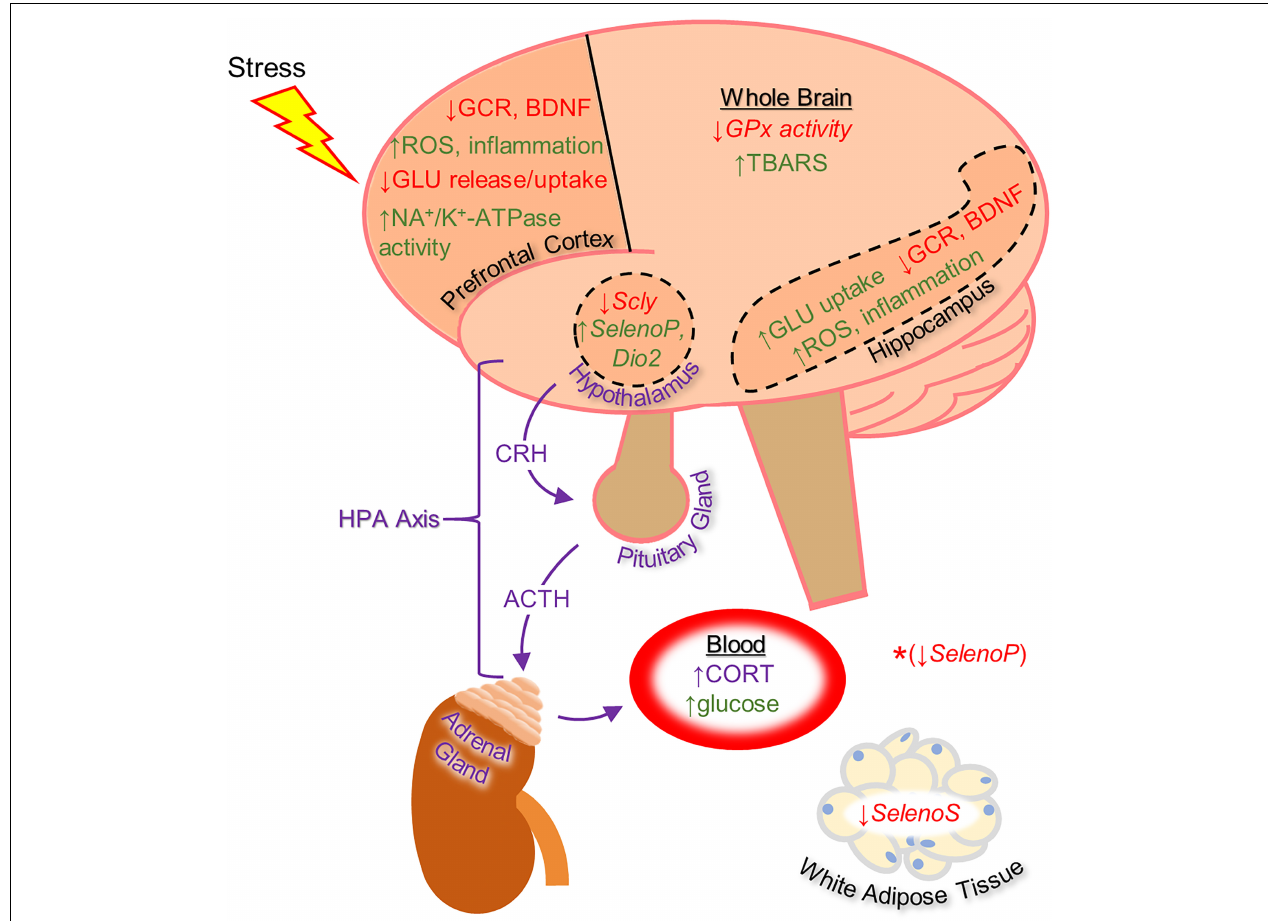
FIGURE 1 | Diagram of the effects of heightened stress on the brain and other tissues as well as on the function of the hypothalamic-pituitary-adrenal (HPA) axis (in purple), based mainly on rodent studies. The effects shown include regulation of selenoprotein expression by glucocorticoid administration (shown with italicized text). *The synthetic glucocorticoid dexamethasone was shown to down-regulate Selenoprotein P gene expression in HEK-293 human embryonic kidney cells. With the exception of changes to selenoprotein expression, the effects listed on this diagram were shown to be reversible by selenium-based therapy. Up-regulation is indicated by green text and down-regulation by red text. ACTH, adrenocorticotropic hormone; BDNF, brain-derived neurotrophic factor; CORT, corticosterone; CRH, corticotropin-releasing hormone; Dio2, Iodothyronine deiodinase 2; GCR, glucocorticoid receptor; GLU, glutamate; GPx, glutathione peroxidase; ROS, reactive oxygen species; Scly, selenocysteine lyase; SelenoP, Selenoprotein P; SelenoS, Selenoprotein S; TBARS, thiobarbituric acid reactive